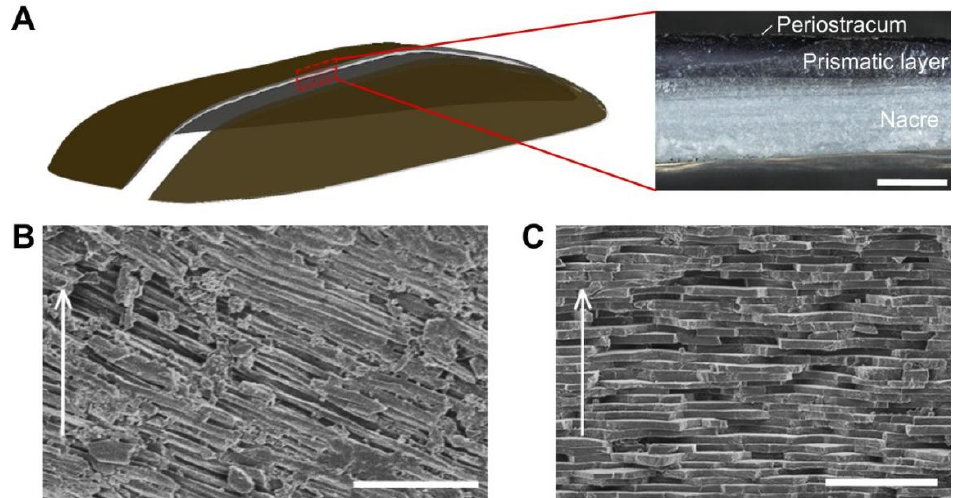
Figure 1. Multiscale structures in Mytilus edulis shells. ( A ) Multilayered structure of the cross-section of the bivalve shell observed under an optical microscope. Three layers are visible from the outside to the inside: the periostracum, the prismatic layer, and the nacre. ( B ) Scanning electron microscopy (SEM) images of oblique-arranged columnar calcite grains situated in the prismatic layer. ( C ) SEM image of the brick-and-mortar-like structure of nacre. White arrows in B and C indicate the normal direction of the shell from the inside to the outside. Scale bars: ( A ), 600 µ m; ( B , C ), 10 µ m. Reproduced from ref. [13] with permission of The Company of